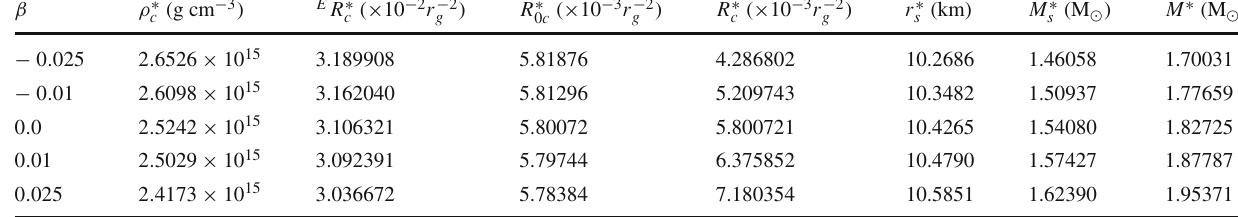
Table 1 Maximum stable mass M ∗ for different values of ω . The corresponding values of stellar mass M ∗ s , stellar radius r ∗ s , central Einstein Ricci scalar E R ∗ c , central Starobynsky Ricci scalar R ∗ , central Ricci scalar R ∗ c and central density ρ ∗ c are also displayed 0 c